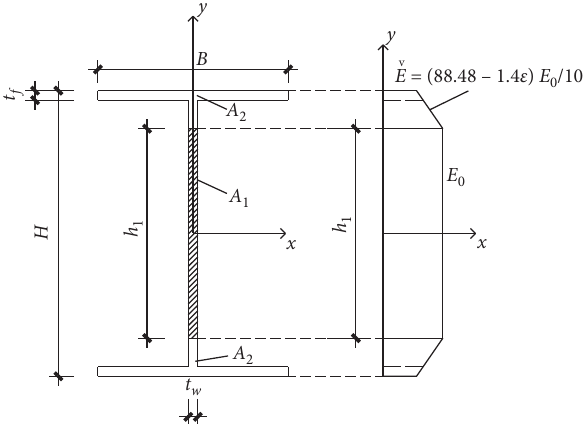
Figure 7: Distribution characteristics of elastic modulus of gen- erally damaged cross section.